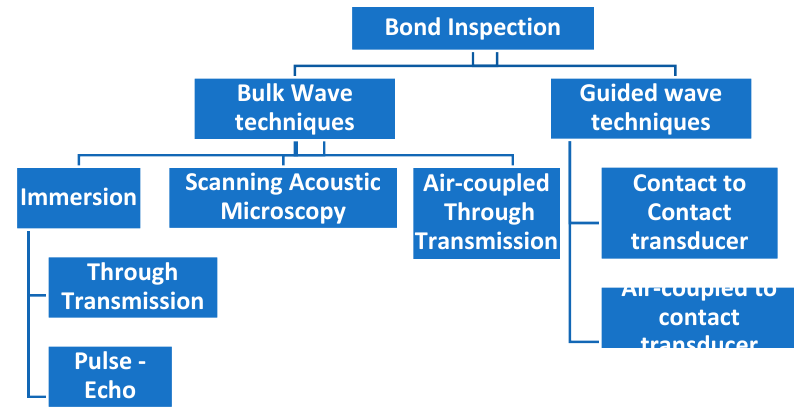
Figure 2. Ultrasonic non-destructive testing methods that were used for adhesive bond inspection.